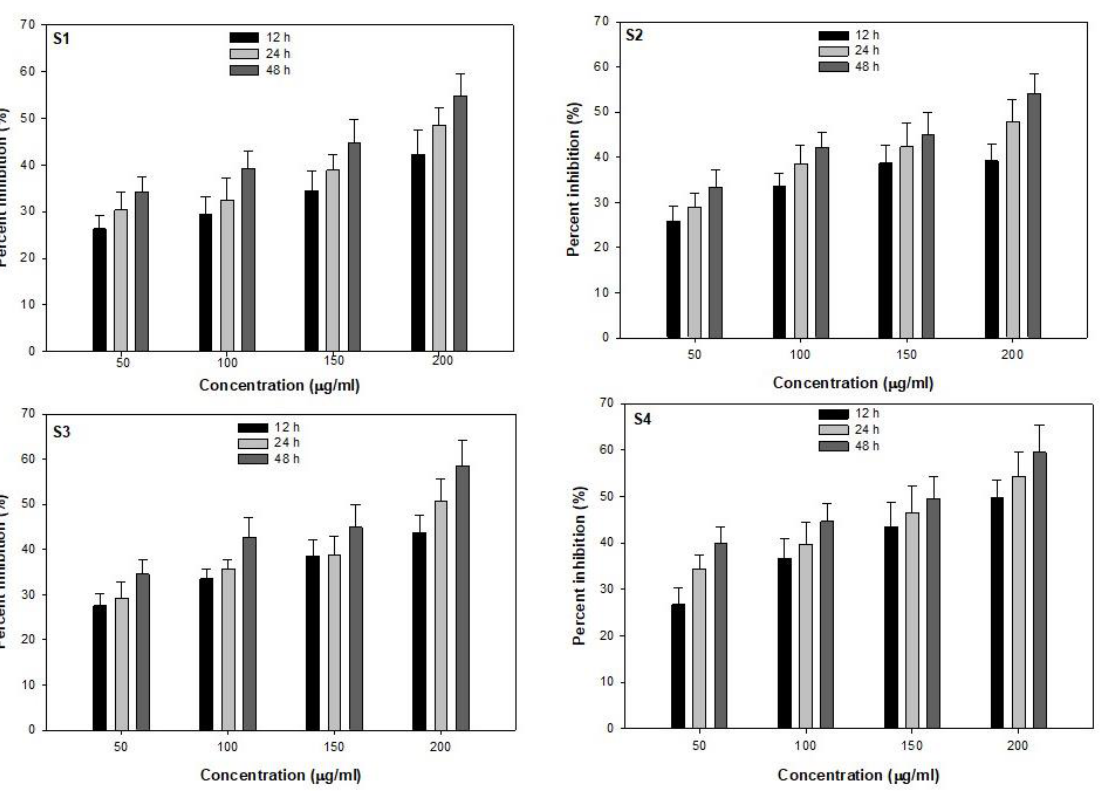
Figure 4. Antibacterial activity of MK-AgNPs against clinical Shigella isolates. Biosynthesized AgNPs act on the bacterial cells by disrupting the cell membrane, leading to subsequent protein leakage [18,32]. We analyzed the protein leakage in MK- AgNP-treated Shigella cells using Bradford assay. The results showed that the protein leakage in MK-AgNPs-treated Shigella isolates (S1, S2, S3, and S4) was recorded as 3.9, 5.2, 5.8, and 4.6 times higher compared to their respective controls (Figure 5a). Thus, it is envisaged that the bactericidal action of MK-AgNPs is due to the high infiltration of the bacterial cell wall by Ag, leading to release of the intracellular contents and cell death. NAntioxidants are materials that neutralize the effects of reactive oxygen species (ROS) and prevent cell damage caused by them. There has been an enormous demand for antioxidants; in particular, natural antioxidants are in huge demand these days due to their ability to prevent diseases and to improve public health. Therefore, MK-AgNPs were tested for their scavenging of DPPH at concentrations ranging from 100–500 µ g/mL. Concentration-dependent free radical scavenging activity was recorded as shown in Figure 5b. At 500 µ g/mL, 82.5% of inhibition of DPPH was recorded as compared to the untreated control. Ascorbic acid was used as a standard. Additionally, FRAP assay was also performed to assess the antioxidant potential of scavenging activity of MK-AgNPs. As evident from Figure 5c, MK-AgNPs reduced 0.88 Fe + / µ g whereas the standard (ascorbic acid) reduced 0.93 Fe + / µ g at 500 µ g/mL. Our findings are in line with those that reported AgNPs synthesized using aqueous extract of M. indica (seed). Photosynthesized AgNPs demonstrated dose-dependent antioxidant activity where DPPH activity of NPs exhibited an inhibition of 16–90% at tested concentrations (160–960 µ g/mL) [23]. The results can be utilized for application of these NPs as antioxidants for various health benefits, especially against oxidative stress-related diseases and